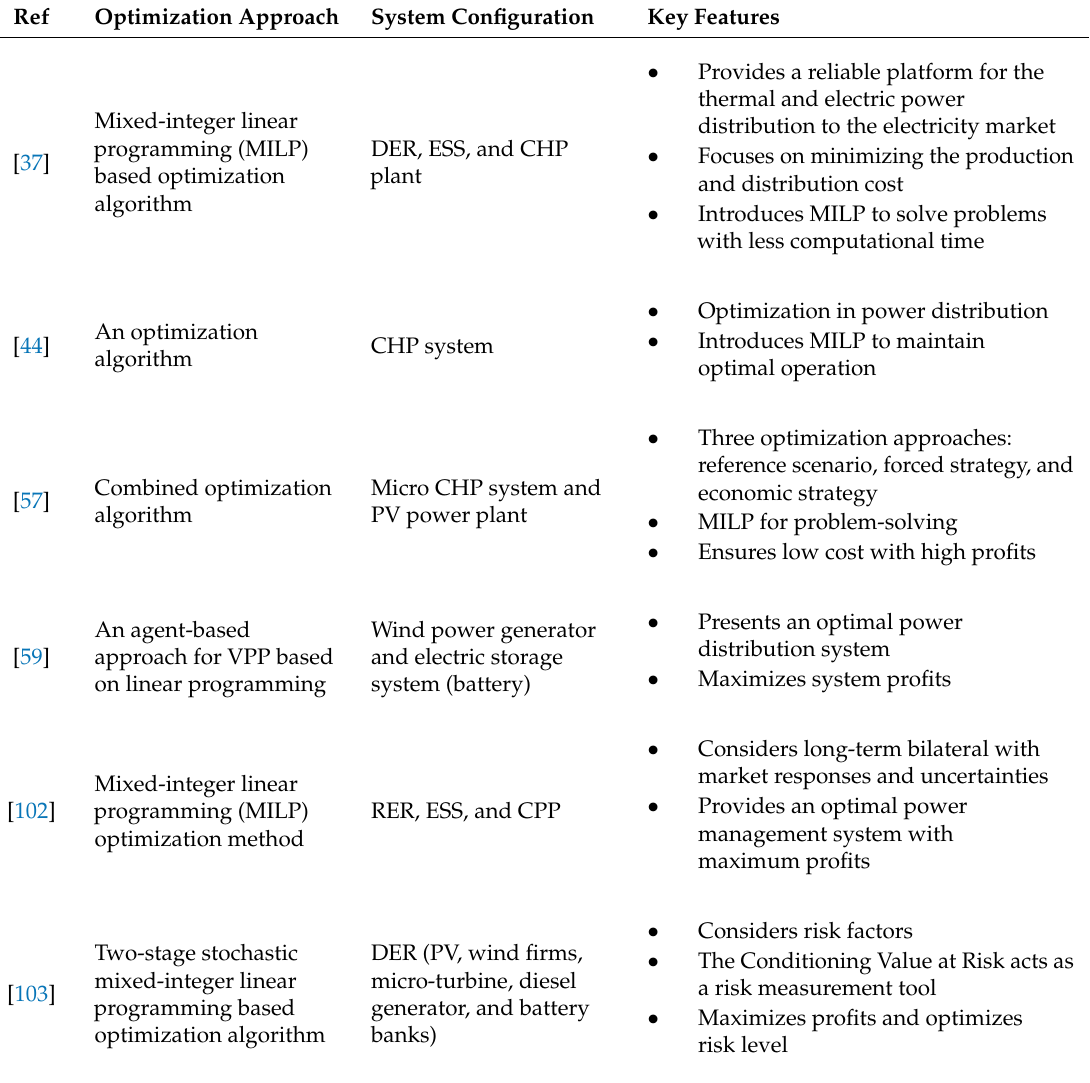
Table 6. A comparative analysis among di ff erent linear programming-based strategies for the virtual power